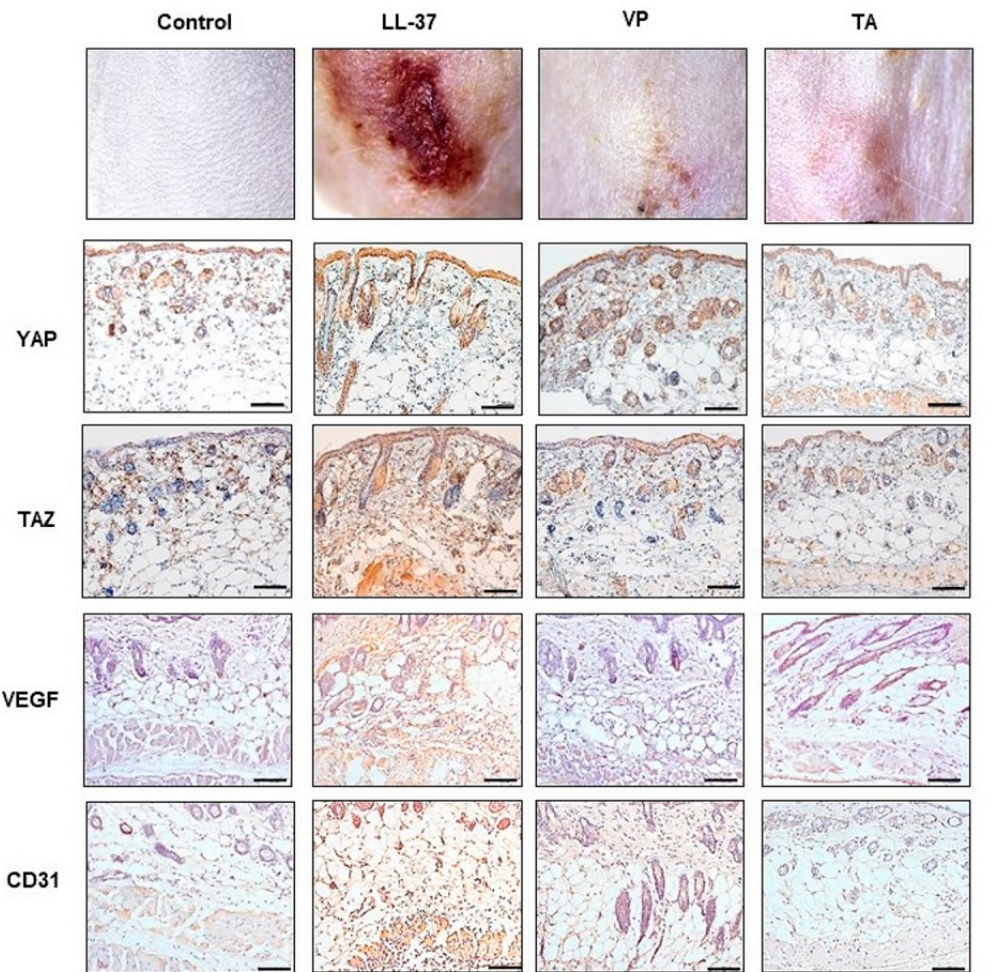
Figure 2. The LL-37-induced rosacea-like mouse model. Representative photomicrographs of YAP- and TAZ-, hematoxy- lin and eosin (H&E)-, and vascular endothelial growth factor (VEGF)-stained skin sections. Original magnification, X200; and TAZ-, hematoxylin and eosin (H&E)-, and vascular endothelial growth factor (VEGF)-stained scale bar = 100 μ m. skin sections. Original magnification, X200; scale bar = 100 µ